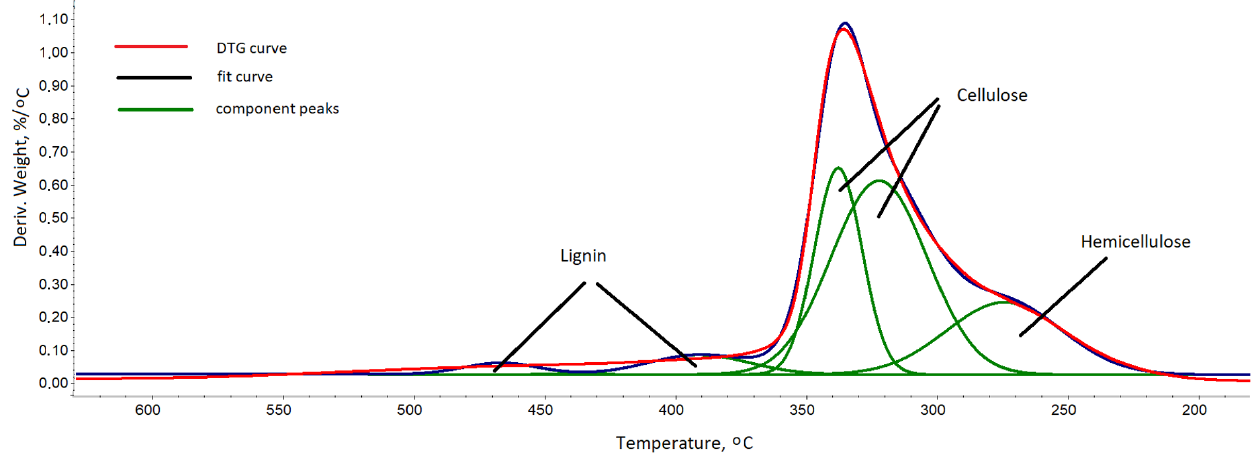
Figure 5. Deconvolution of ARBOCEL ® P 4000 X multiplet peak from DTG analysis into component peaks.